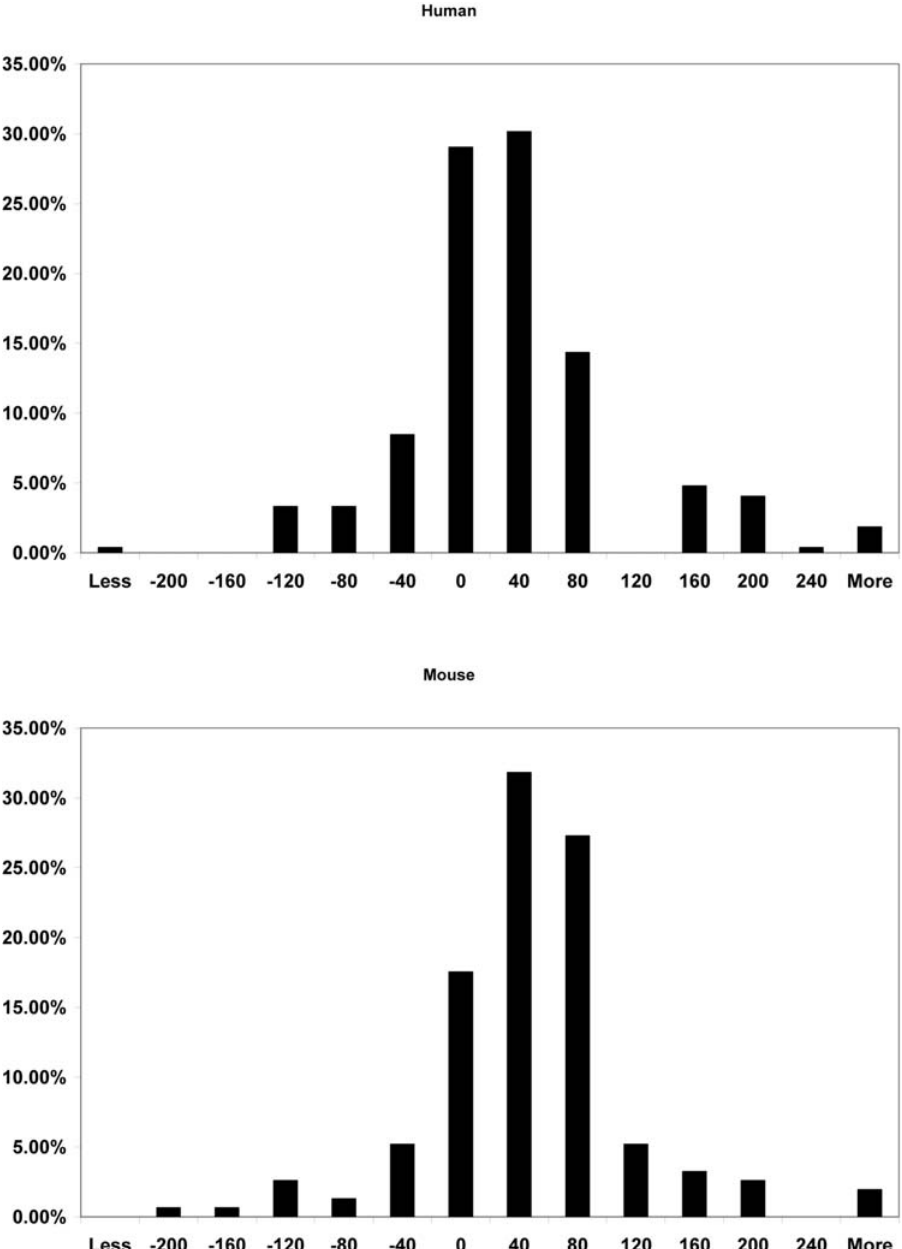
Figure 2. Histogram of the distances between the ETS and TCF/LEF binding sites on the promoter sequences of human and mouse genes co-expressed in ESCs. The distances were calculated based on the midpoint of binding sites from 272 (human) or 154 (mouse) proximal promoters bound by the two transcription factors. Negative or positive values on the plot indicate ETS is upstream or downstream of TCF/LEF on the promoter sequence. About 75% of the genes in the conserved co-expression clusters show an 80-bp or less distance between ETS and TCF/LEF binding sites in both human and mouse. The juxtaposed ETS and TCF/LEF binding motifs on the promoter sequences provides evidence of the FGF response element (FRE) in the conserved co-expression clusters of ESC-critical